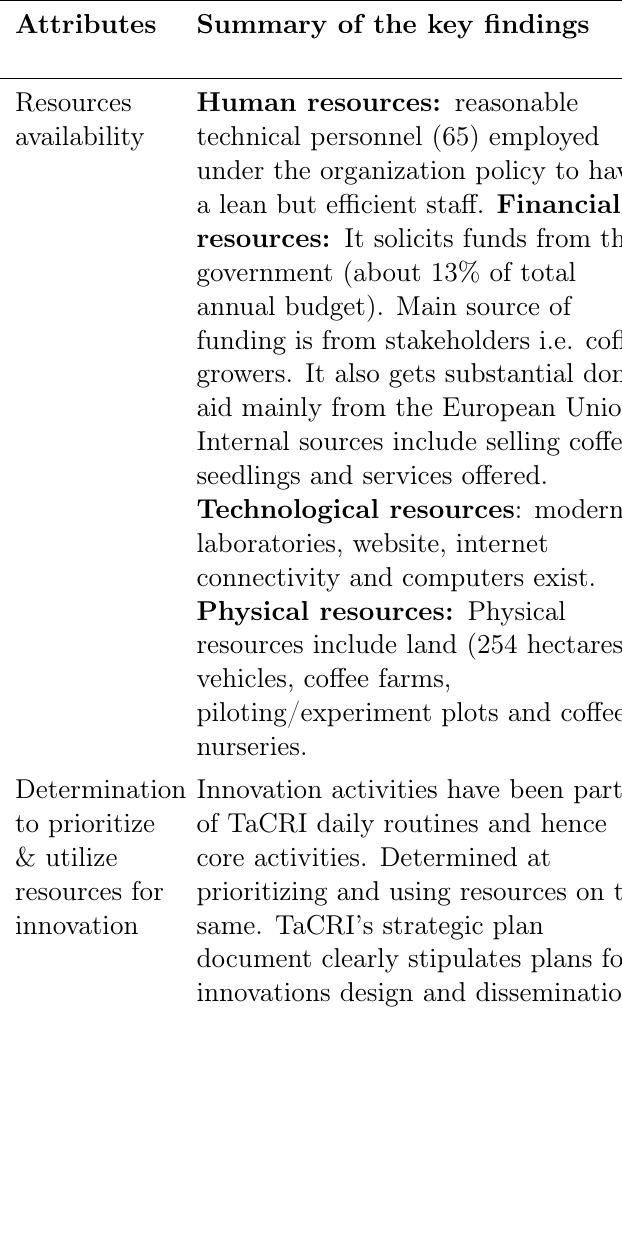
Reasons for the rating